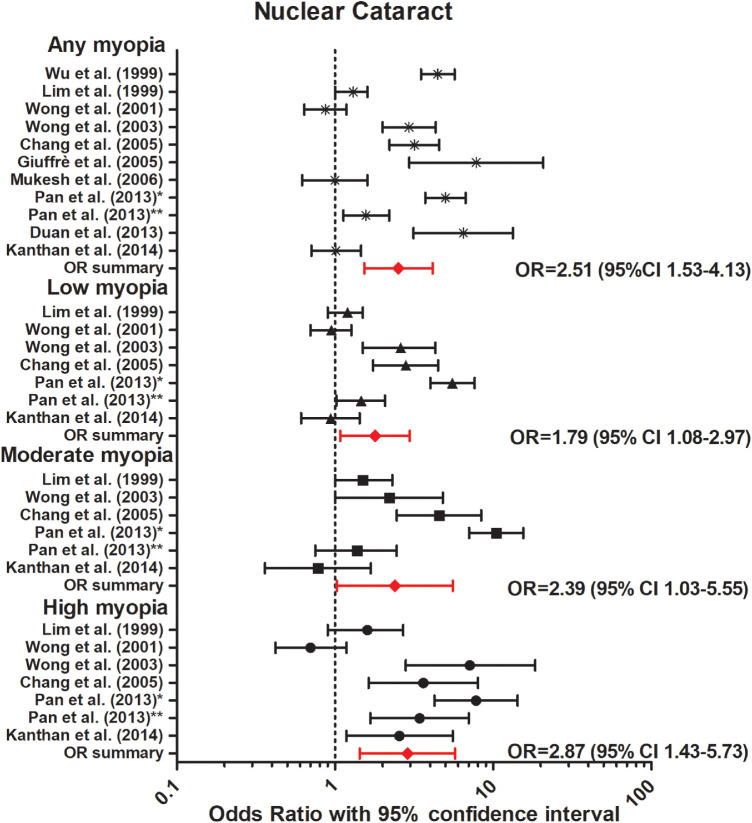
Forest plot of nuclear cataract in any myopia (random effects model; Q = 9.3; I2 = 0); low myopia (random effects model; Q = 5.7; I2 = 0); moderate myopia (random effects model; Q = 4.0; I2 = 0.0); and high myopia (random effects model; Q = 5.0; I2 = 0.0). Red lines with diamond represents the summary OR per myopia category, which are as follows: any myopia OR, 2.51 (95% CI, 1.53–4.13); low myopia OR, 1.79 (95% CI, 1.08–2.97); moderate myopia OR, 2.39 (95% CI, 1.03–5.55); and high myopia OR, 2.87 (95% CI, 1.43–5.73). *Represents Pan et al.60 2013 Singapore Malay Eye Study. **Represents Pan et al.61 2013 Singapore Indian Eye Study.